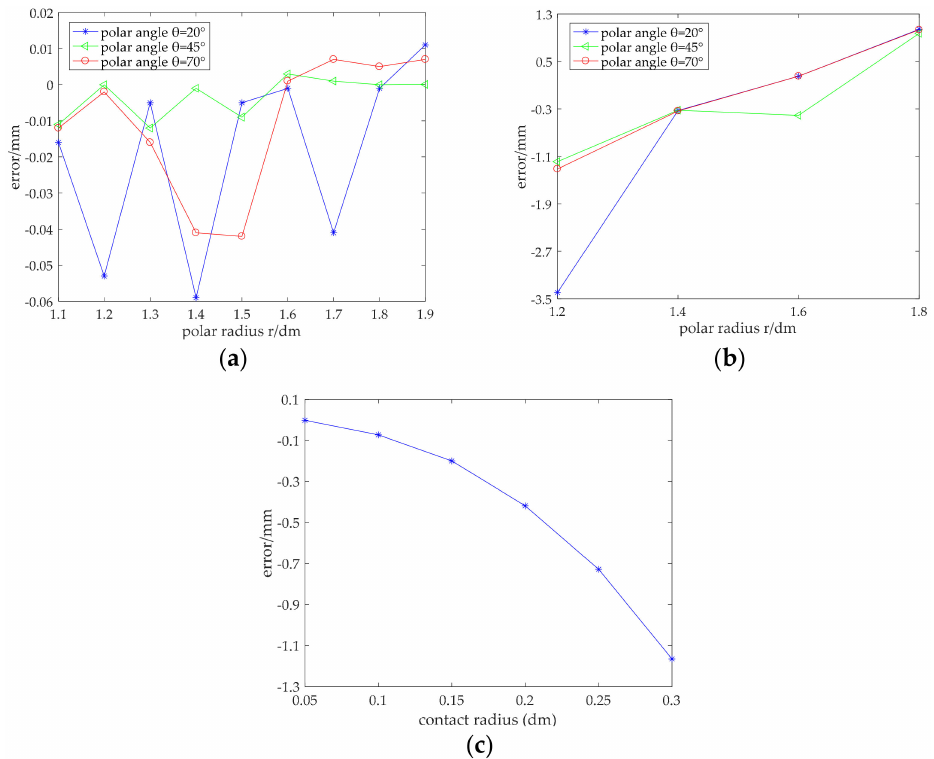
Figure 11. Detection precision of the polar radius: ( a ) error diagram of the polar radius under the point contact; ( b ) error diagram of the polar radius with surface contact; ( c ) influence of contact area on